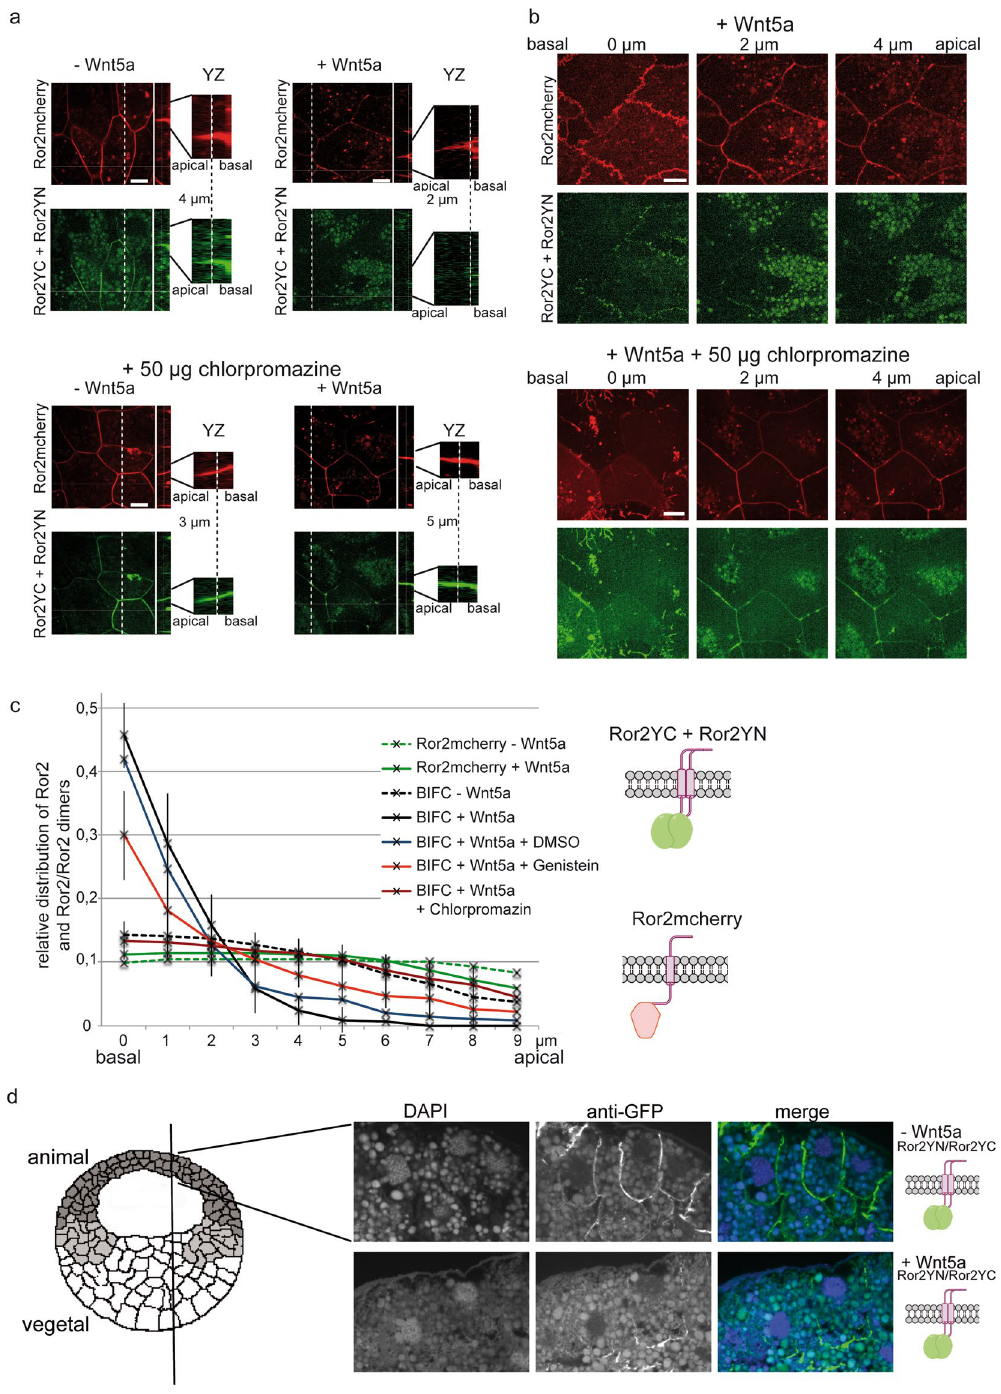
Figure 5. Wnt5a induces disappearance of Ror2/Ror2 dimers at the apical membrane. ( a ) Animal cap explants were analyzed for the localization of total Ror2 (Ror2mCherry, red channel) and Ror2 homodimers (splitYFP signal, green channel) in the absence ( − Wnt5a) and presence ( + Wnt5a) of co-injected Wnt5a and in the presence of 50 µ g chlorpromazine. Ten optical sections of 1 µ m thickness allowed us to visualize localization of the signals in the z-dimension. The white bar in the close-ups of the yz-plane marks the z-coordinate shown in the xy-images. ( b ) xy-planes at three different z-values illustrate the exclusively basal and basolateral localization of Ror2/Ror2 dimers in Wnt5a co-injected explants. ( c ) To quantify the z-distribution of the fluorescence signals, at least 11 explants (each with 4 to 6 different cells) derived from 3 independent experiments were analyzed. Individual fluorescence spots were selected in the maximum intensity projections, and the images were analyzed section by section for visibility of these spots. Shown is the fraction of fluorescence spots found in the xy-images as a function of the z-coordinate from basal (0 µ m) to apical (9 µ m). These data were calculated for each cell by dividing the number of fluorescence spots of a particular xy-plane by the number of spots in all planes. Shown are mean values and standard deviations from at least 11 explants. It is apparent that the